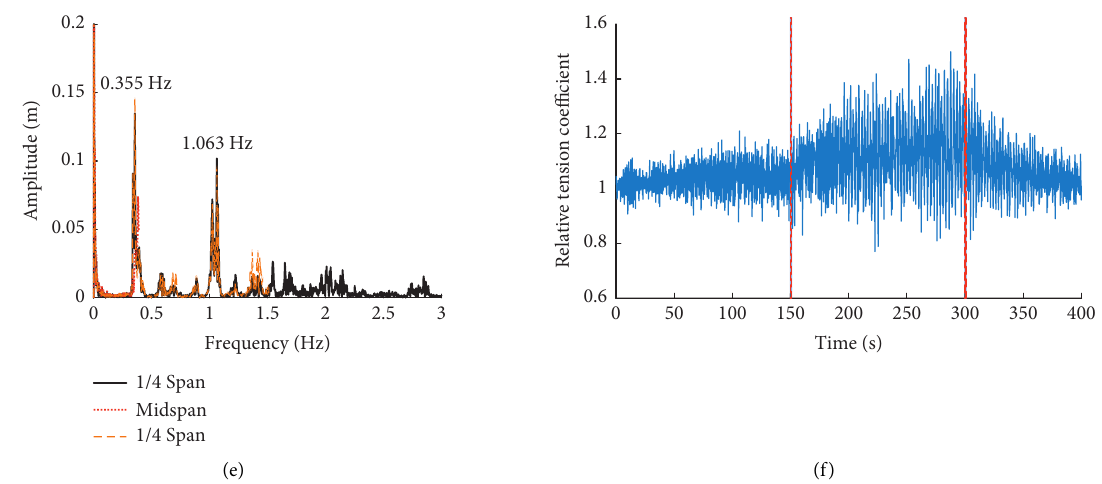
Figure 16: Results of the whole process simulation: (a) Vertical displacement at the excitation point. (b) Vertical displacement at 1/4 point of the line. (c) Vertical displacement at midspan. (d) Vertical displacement at 3/4 point of the line. (e) The amplitude spectrum. (f) Dynamic relative tension coefficient with